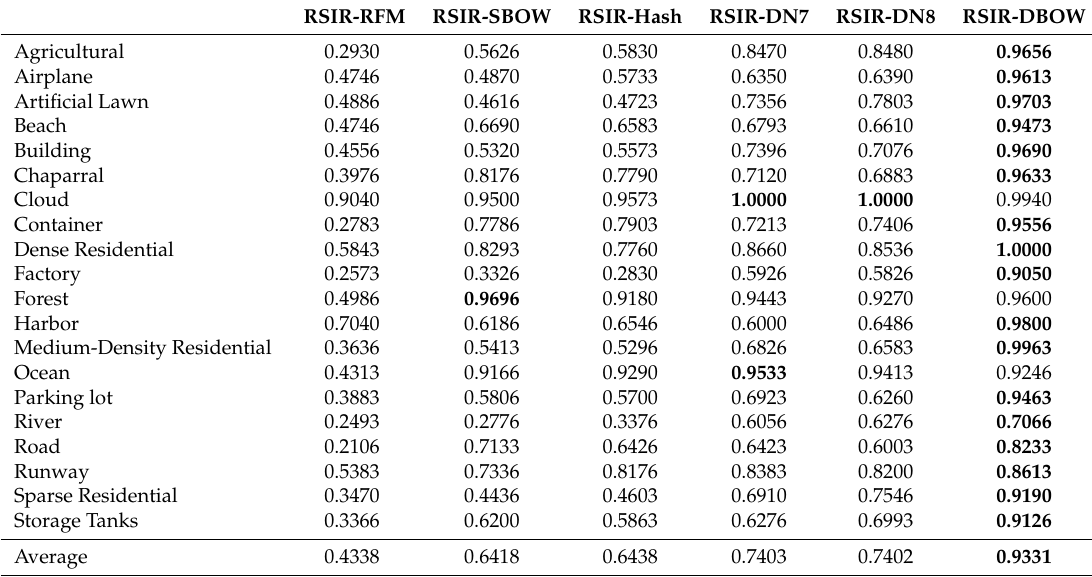
Table 4. Retrieval precision of different RSIR methods across 20 semantic categories in ImgDB2 counted by the top 20 results.